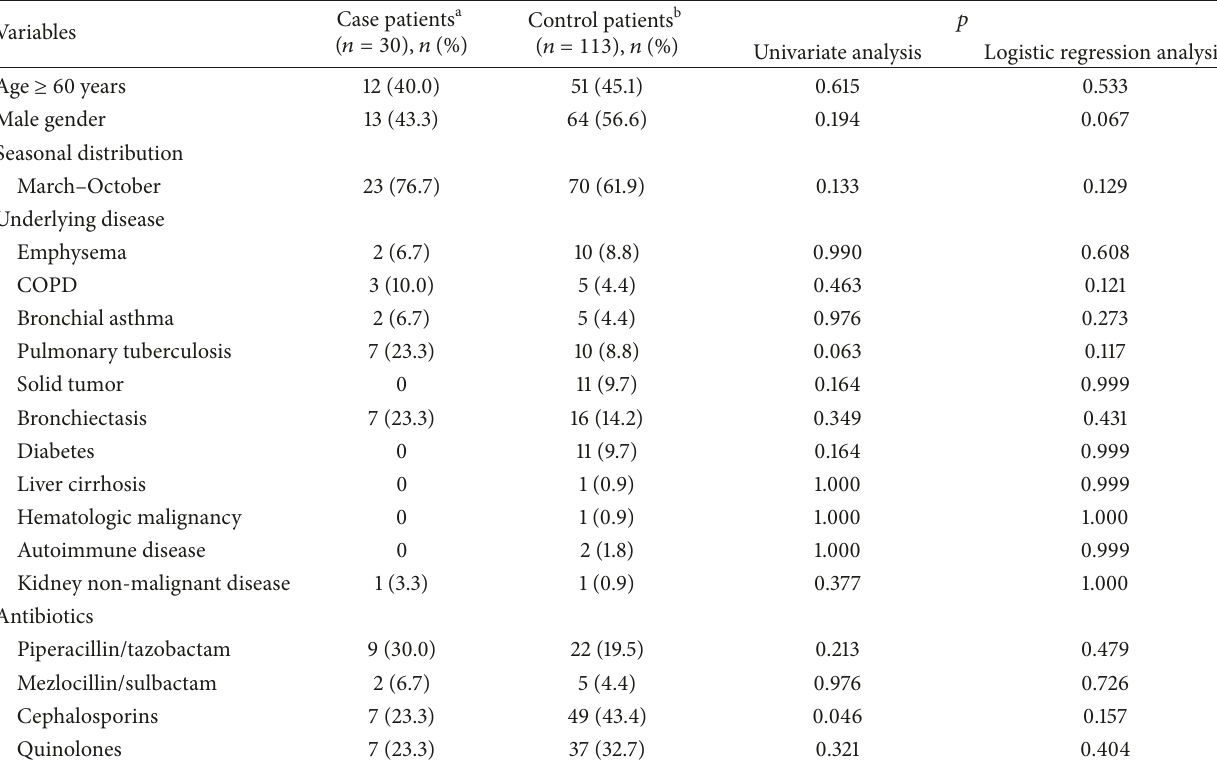
Table 4: Risk factors for false-positive galactomannan results in bronchoalveolar lavage assays with univariate analysis and logistic regression analysis,